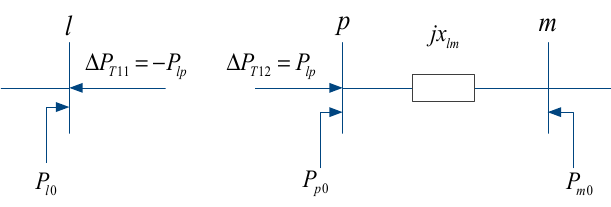
Figure 3. Equivalent schematic diagram of TCSC1.